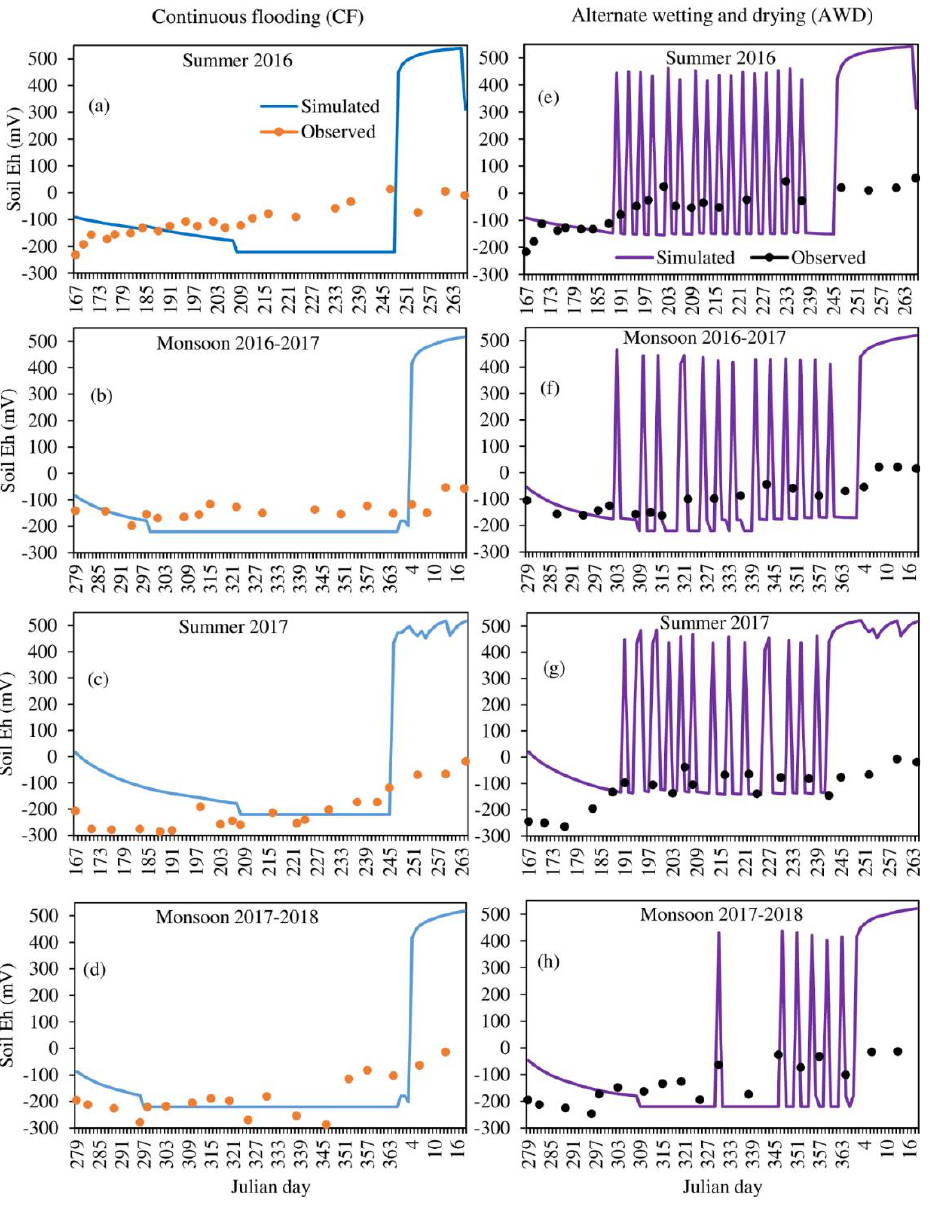
Figure 2. Observed and simulated soil redox potential under continuous flooding ( a – d ) and alternate wetting and drying conditions ( e – h ) during different rice-growing seasons.